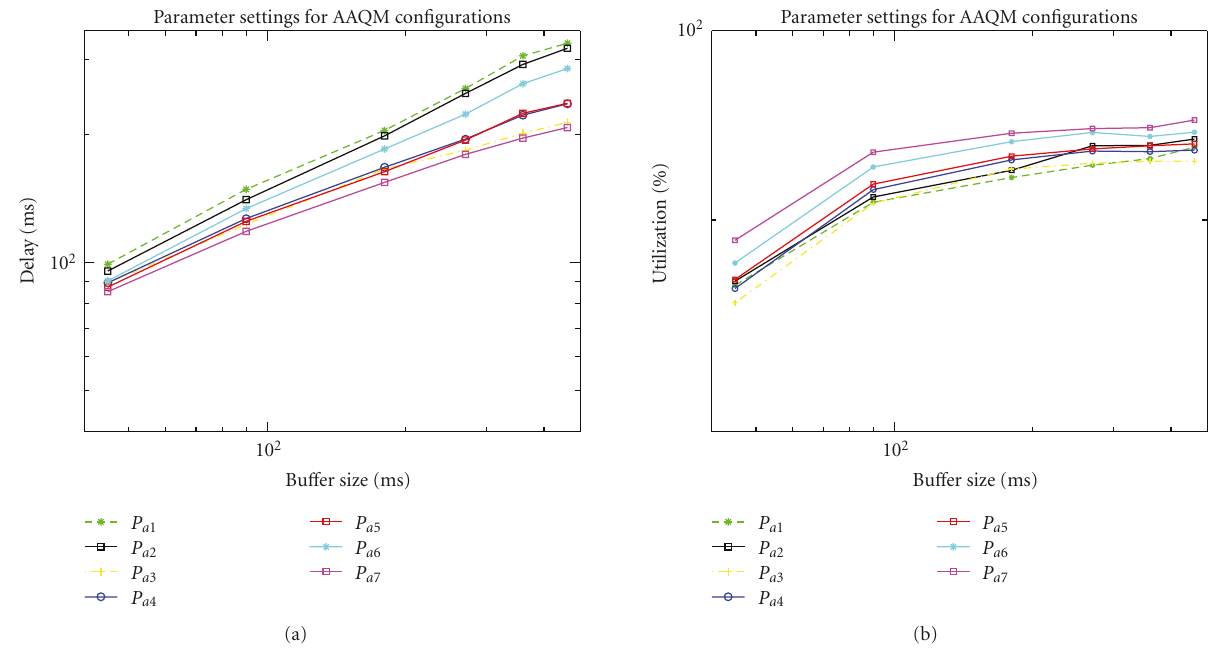
Figure 5: The parameter settings for AAQM configuration for performance metrics (a) delay (b) utilization.